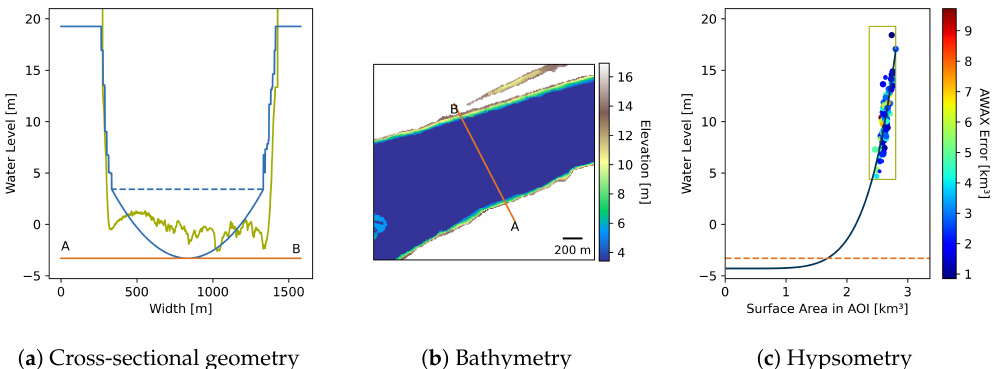
Figure 12. Estimated geometry, bathymetry, and hypsometry at Tarbert Landing (CS 492.5). For details see Figure